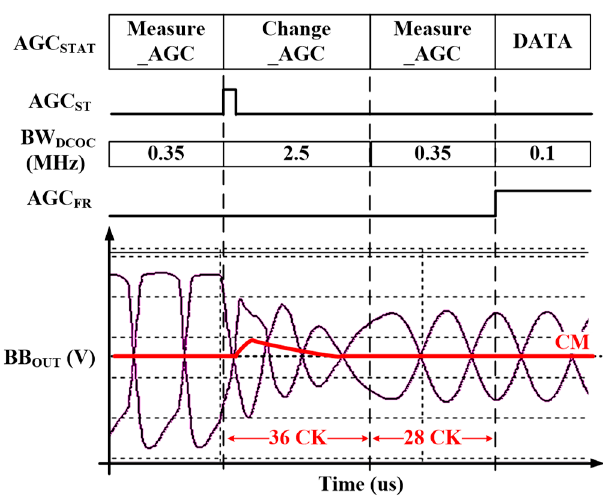
Figure 26. The simulation result of the DC-OC Controller.